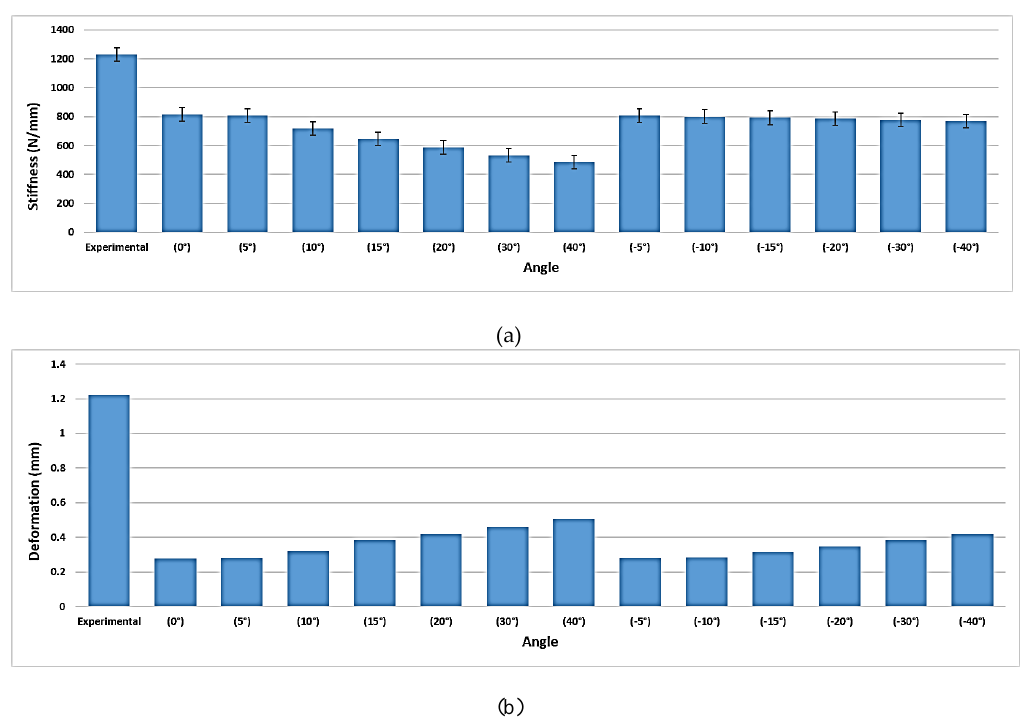
Figure 12. ( a ) The stiffness for the experimental work versus VALS FE results. ( b ) The displacement for the experimental work versus the VANS FE results.